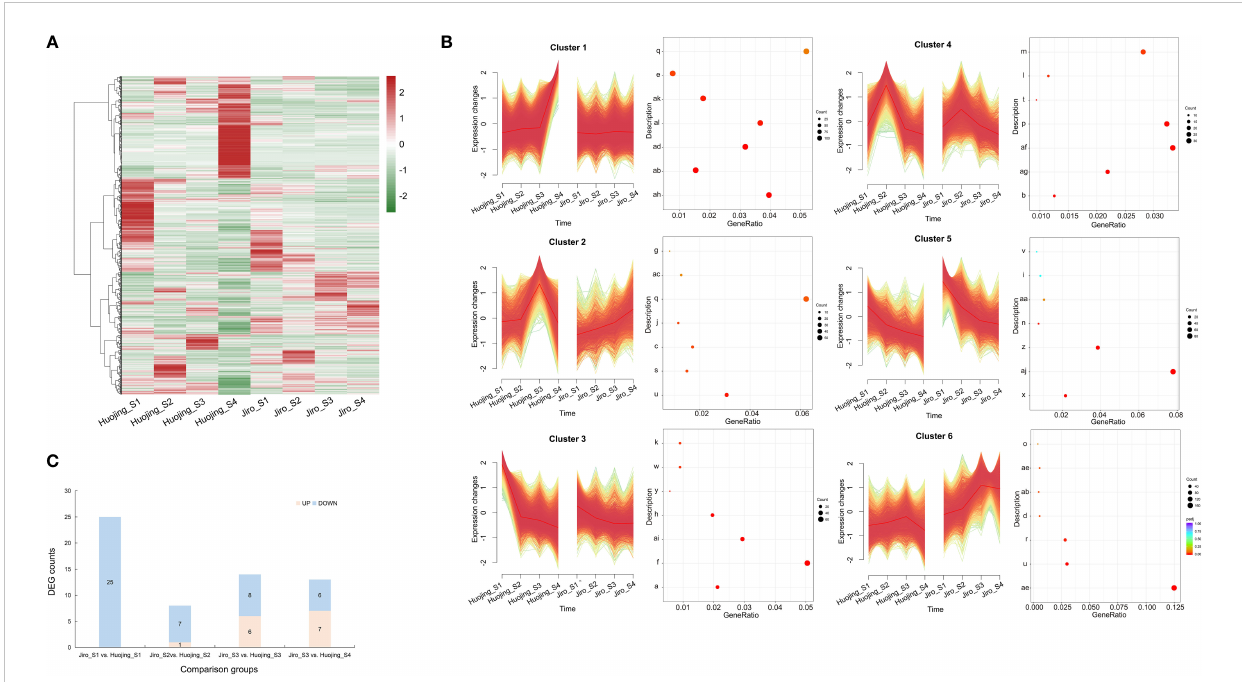
FIGURE 3 Expression patterns and KEGG analysis of genes in the transcriptomes of PCNA and PCA fruit. (A) Heatmap showing the overall common expression pattern. Heatmaps were constructed using the normalized gene expression values. (B) Expression pro fi les and KEGG annotations of six clusters. The y-axis of each cluster represents the KEGG categories, while the x-axis represents the rich factors. Red dots represent signi fi cantly overrepresented KEGG pathways. (C) Summary of fl avonoid-associated DEGs in different comparison groups of ‘ Jiro ’ and ‘ Huojing ’ . a, ABC transporters; b, alpha- Linolenic acid metabolism; c, Amino sugar and nucleotide sugar metabolism; d, Arachidonic acid metabolism; e, Autophagy- other; f, Chromosome and associated protein; g, Circadian rhythm-plant; h, Cytoskeleton proteins; i, Exosome; j, Fatty acid biosynthesis; k, Flavonoid biosynthesis; l, Glycine, serine and threonine metabolism; m, Glycosyltransferases; n, Ion channels; o, Lipopolysaccharide biosynthesis proteins; p, MAPK signaling pathway-plant; q, Membrane traf fi cking; r, Mitochondrial biogenesis; s, N-Glycan biosynthesis; t, Nitrogen metabolism; u, Oxidative phosphorylation; v, Phagosome; w, Phenylalanine, tyrosine and tryptophan biosynthesis; x, Photosynthesis; y, Photosynthesis-antenna proteins; z, Plant hormone signal transduction; aa, Porphyrin metabolism; ab, Promasome; ac, Protein export; ad, Protein processing in endoplasmic reticulum; ae, Ribosome; af, Ribosome biogenesis; ag, Ribosome biogenesis in eukaryotes; ah, Spliceosome; ai, Starch and sucrose metabolism; aj, Transcription factors; ak, Transcription machinery; al, Ubiquitin